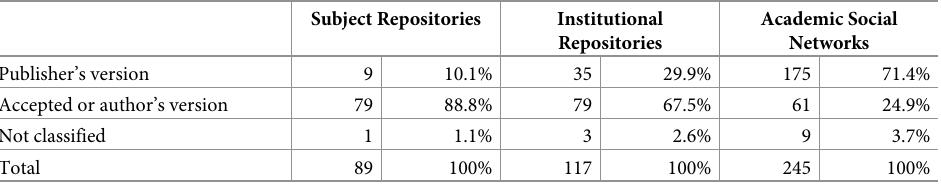
Table 6. Versions available through a single mode in